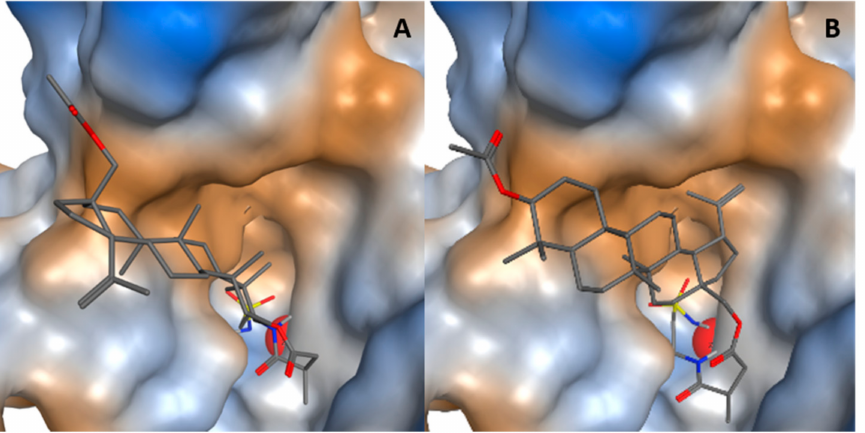
Figure 7. Docking poses of betulin sulfonamides 13b and 15b in the binding pocket of CA IX (PDB: 6g9u). The predicted binding modes of 13b ( A ) and 15b ( B ). The binding pocket of CA IX is colored as a molecular surface according to lipophilicity (brown: lipophilic, blue: hydrophilic, white: neutral). The zinc ion is shown as a red sphere.